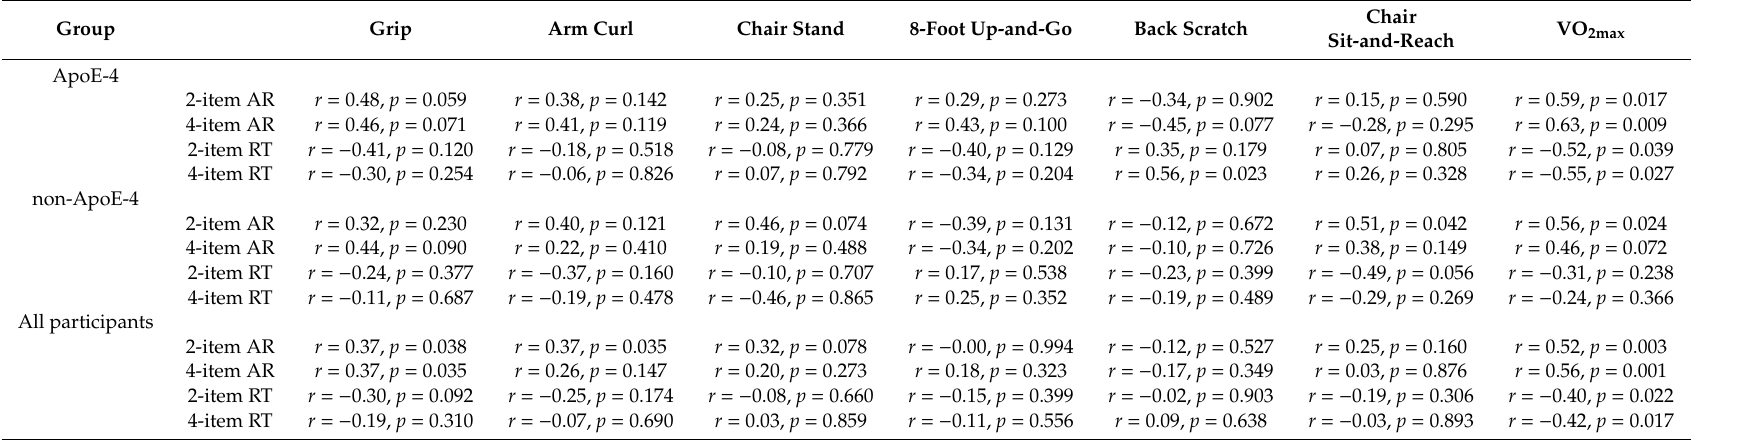
Table 3. The relationships between senior functional physical fitness / cardiorespiratory tests and neuropsychological performance in the visuospatial working memory paradigm in the ApoE-4 and non-ApoE-4 groups and all